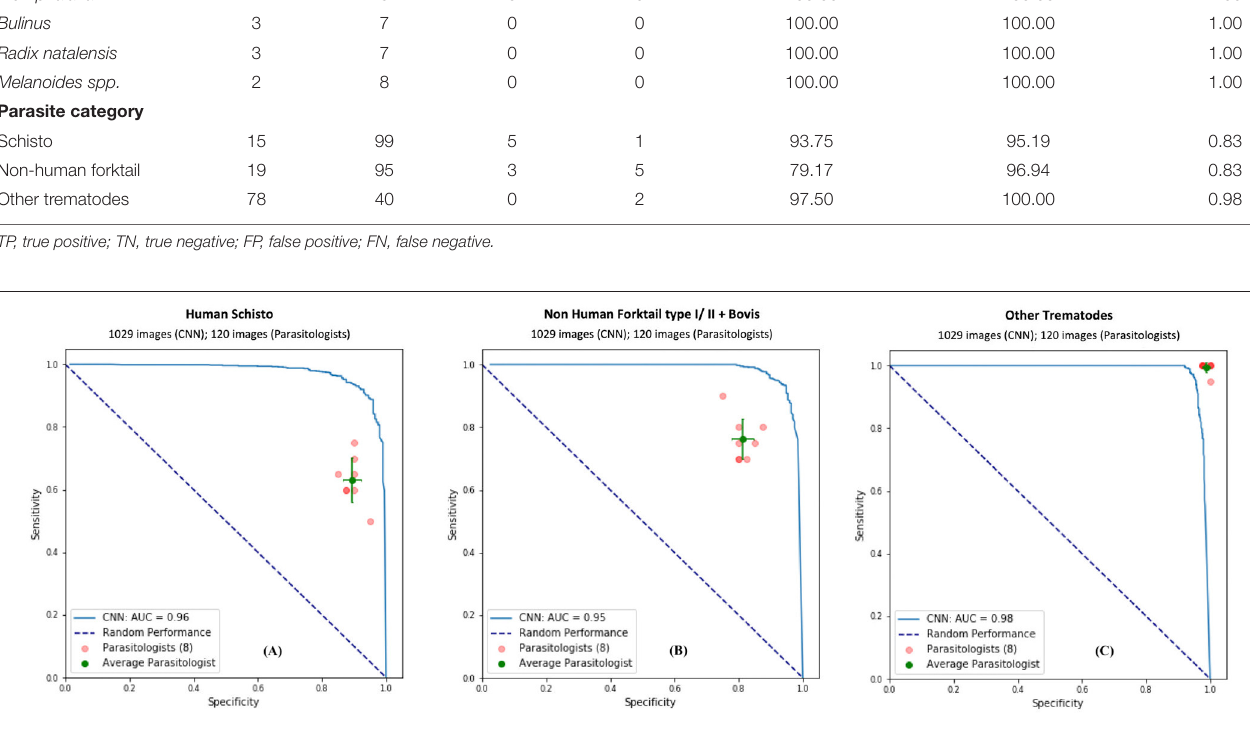
FIGURE 4 | Comparison of classification performance with CNN and parasitologist. CNN’s performance represented by the ROC curve (in blue) exceeds that of trained parasitologists when their sensitivity and specificity points (in red) fall below the ROC curve. The green points represent the average of the parasitologists (average sensitivity and specificity of all red points), with error bars denoting one standard deviation. We simplify the 11 categories of parasite to only three categories of interest for schistosomiasis environmental risk mapping: (A) human schistosomes, (B) non-human forktail cercariae, and (C) other trematode morphotypes. The area under the curve (AUC) for each case is over